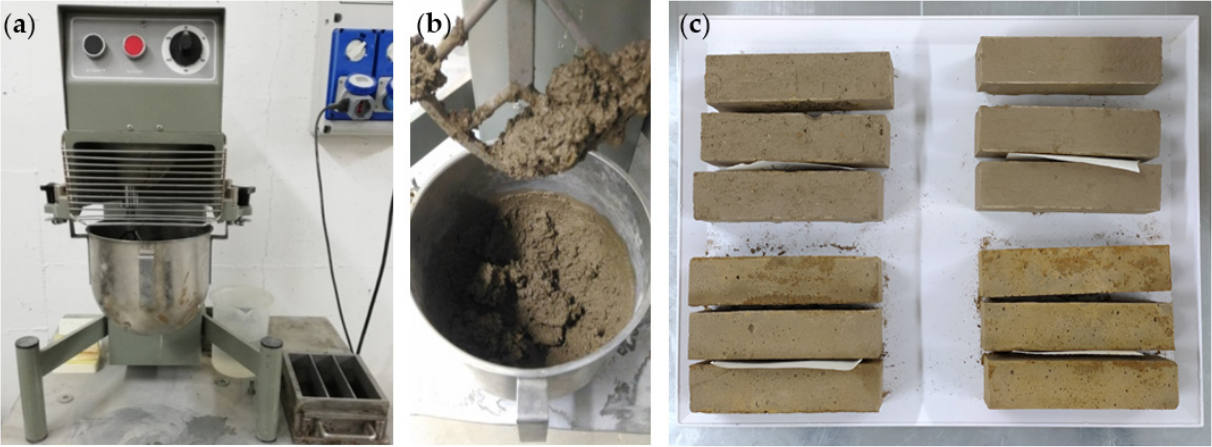
Figure 11. Manufacturing of earth mortar specimens: ( a ) equipment; ( b ) earth mortar mix design; and ( c ) prismatic specimens.